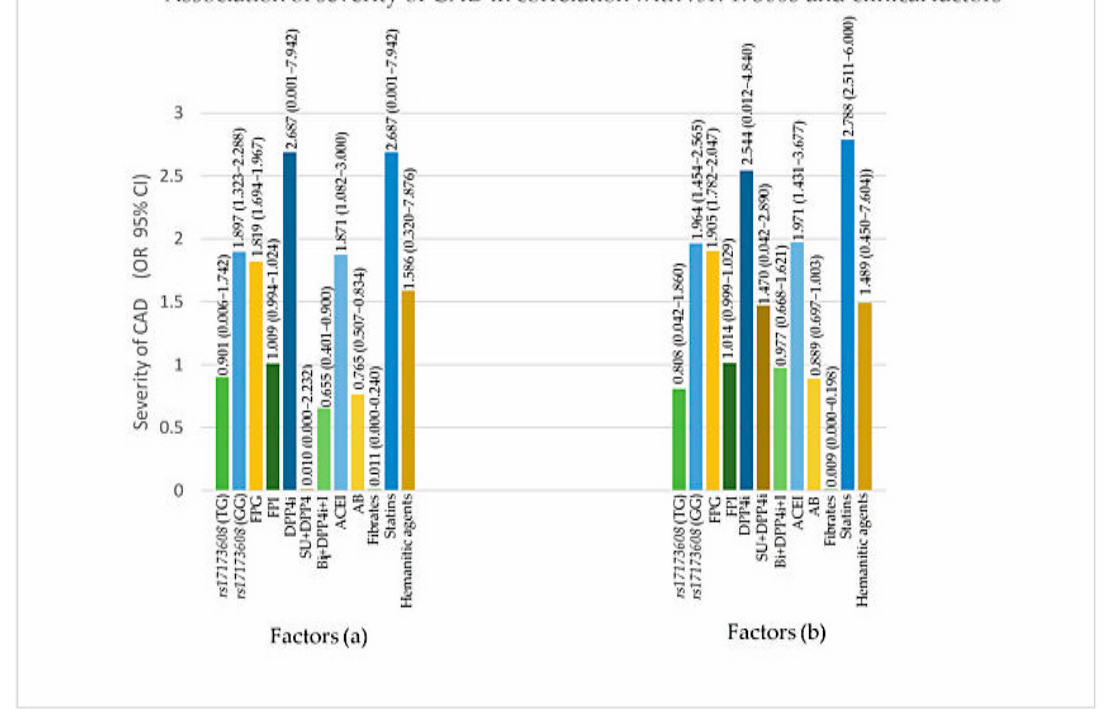
Figure 4. Association of severity of CAD in correlation with rs17173608 and clinical factors. (a) SVD vs. DVD, (b) SVD vs. TVD. FPG: fasting plasma glucose; FPI: fasting plasma insulin; AB: alpha blockers; ACEI: angiotensin-converting-enzyme inhibitor; DPP4i: dipeptidyl peptidase ‐ 4 inhibitor; I: insulin; SU: sulphonylureas.